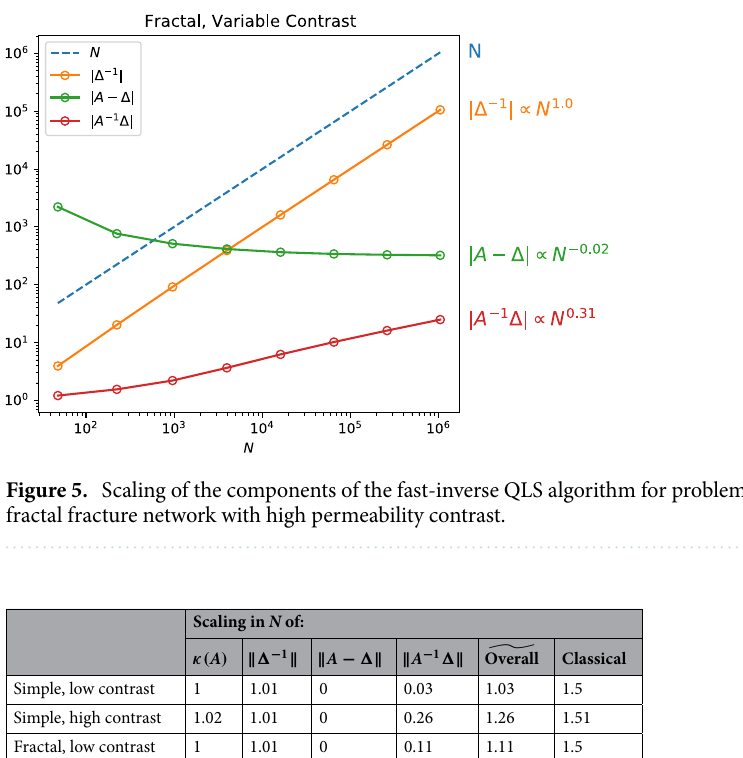
Table 1. Scaling of the various components entering the overall scaling of the fast-inverse QLS using (cid:31) − (cid:31) Overall scaling reported is modulo log ( N ) . the preconditioner. The